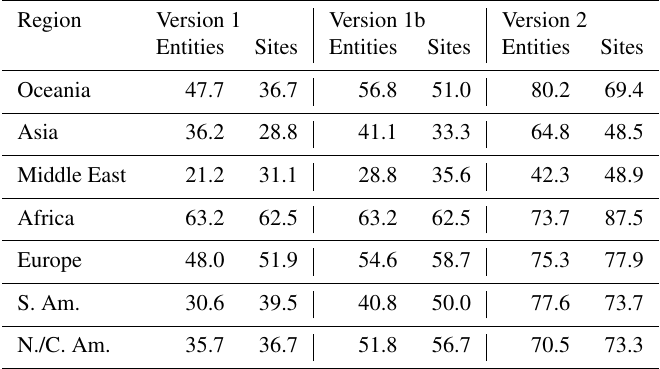
Table 6. Percentage of entities uploaded to the different versions of the SISAL database with respect to the number of records identified by the SISAL working group as of November 2019. The number of identified records includes potentially superseded speleothem records. Regions are defined as: Oceania ( − 60 ◦ < Lat < 0 ◦ ; 90 ◦ < Long < 180 ◦ ), Asia (0 ◦ < Lat < 60 ◦ ; 60 ◦ < Long < 130 ◦ ), Middle East (7 . 6 ◦ < Lat < 50 ◦ ; 26 ◦ < Long < 59 ◦ ), Africa ( − 45 ◦ < Lat < 36 . 1 ◦ ; − 30 ◦ < Long < 60 ◦ ; with records in the Middle East region removed),